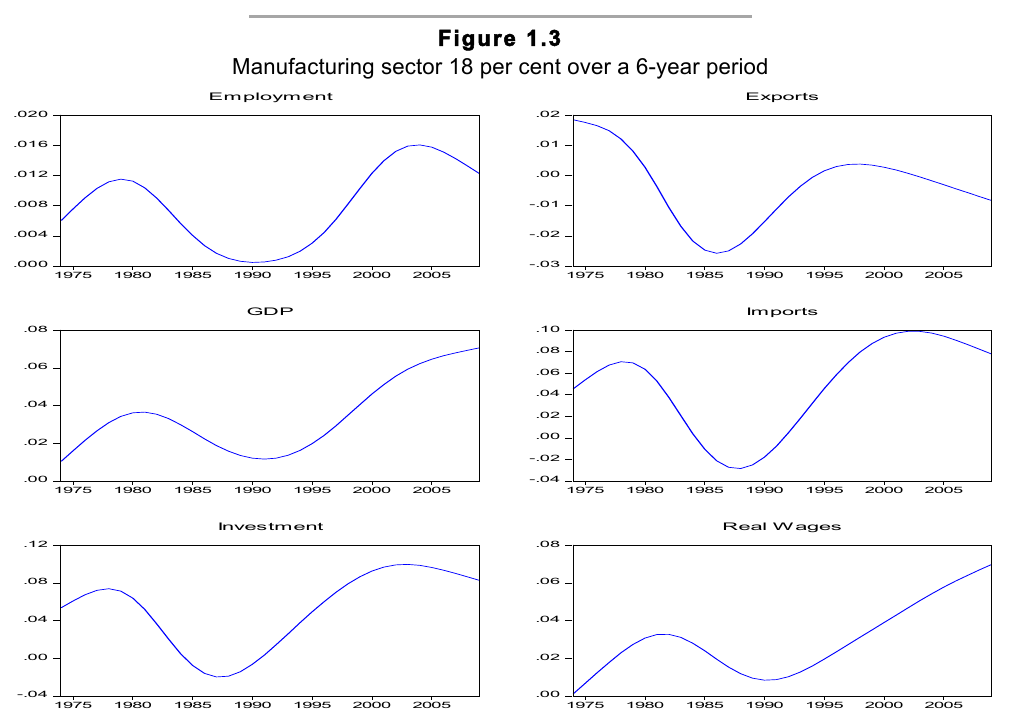
Manufacturing sector 18 per cent over a 6-year